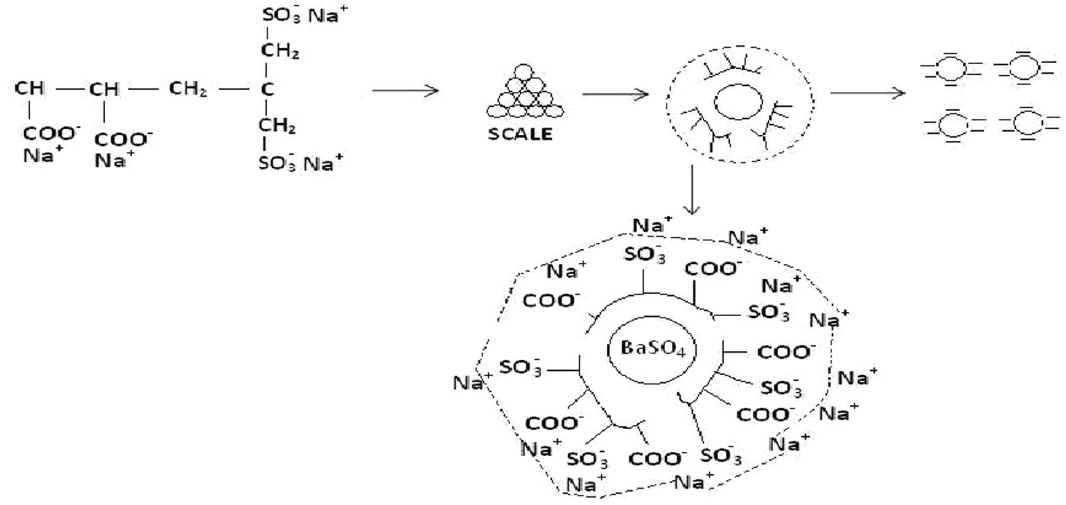
Fig. 11 Formation of electric double layer due to the effect of MA-SMADS